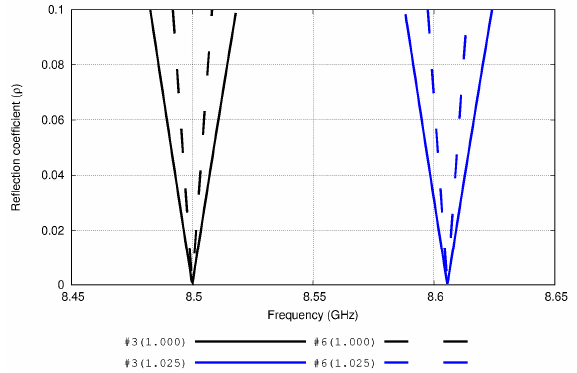
Figure 7. Reflection coe ffi cients of antennas 3 and 6 (Table 2) at di ff erent frequencies in di ff erent media ( ε r = 1.000 and ε r = 1.025 respectively). The resonant frequency is shifted in 106 MHz for both cases. This shift is independent of the selection of the antenna.